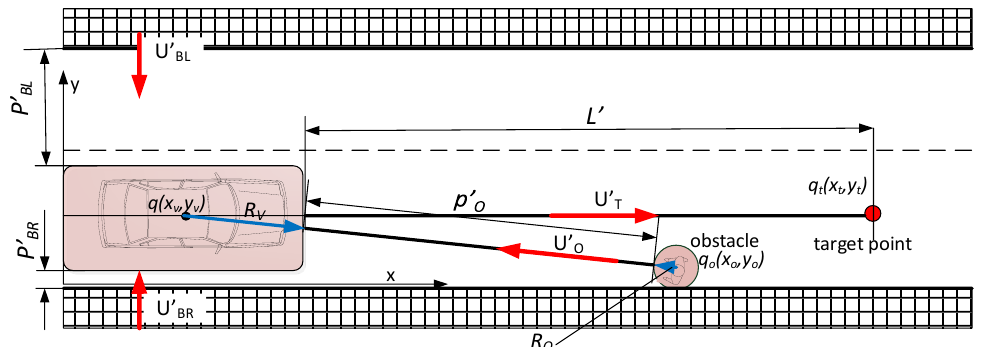
Figure 4. Introduction of vehicle and obstacle safety zones to the situation scheme.